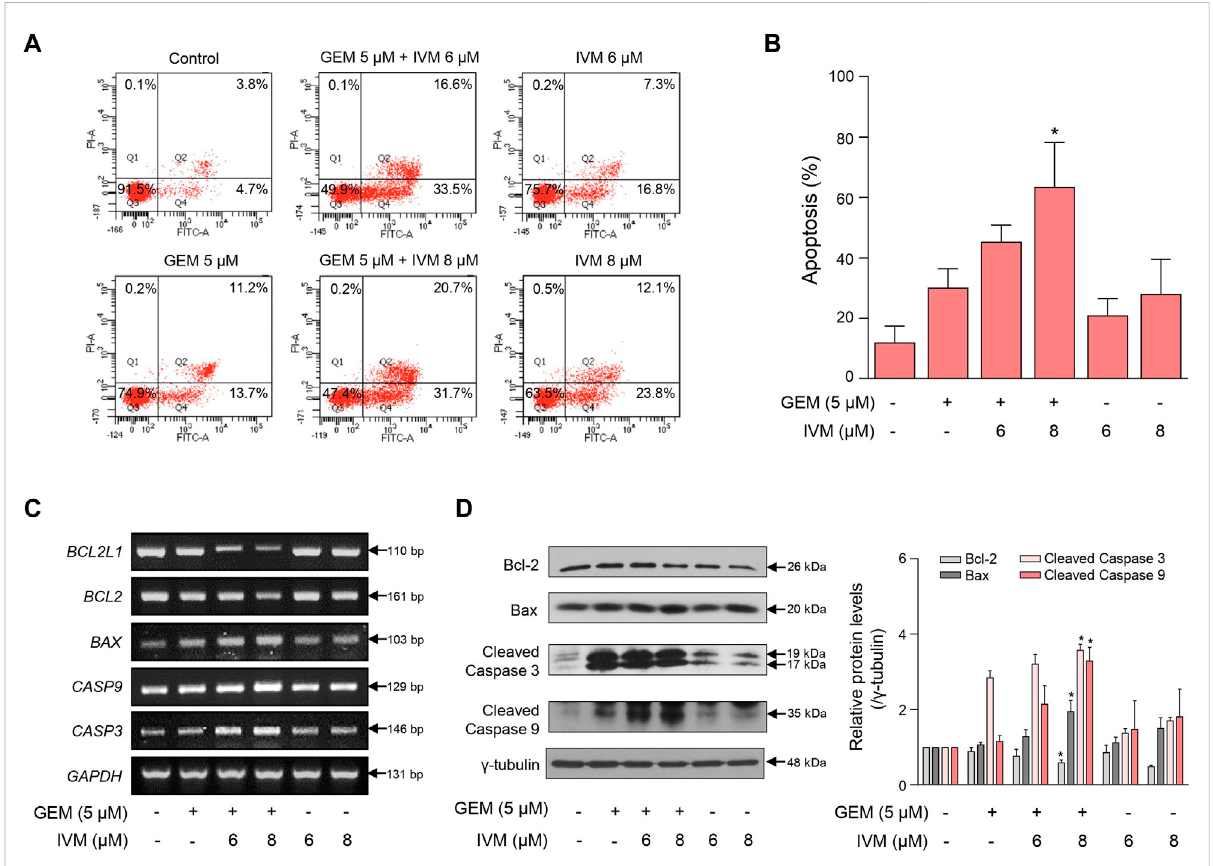
FIGURE 3 Ivermectin and gemcitabine combination increases cell apoptosis. (A) MIA PaCa-2 cells were treated with the indicated concentrations of gemcitabine and ivermectin for 48 h. Apoptosis of MIA PaCa-2 cells was analyzed using fl uorescence-activated cell sorting (FACS) after Annexin V- fl uorescein isothiocyanate (FITC) staining. (B) Graph showing the percentage of cells in early and late apoptosis Data represents the mean ± SD ( n = 3). * p < 0.05 and ** p < 0.01 compared with the gemcitabine alone group. (C) mRNA expression levels in cells treated with the ivermectin and gemcitabine combination for 48 h were determined using PCR. (D) Protein expression levels were determined using western blotting after ivermectinandgemcitabinetreatment.Datarepresentsthemean±SD( n =3).* p < 0.05and** p <